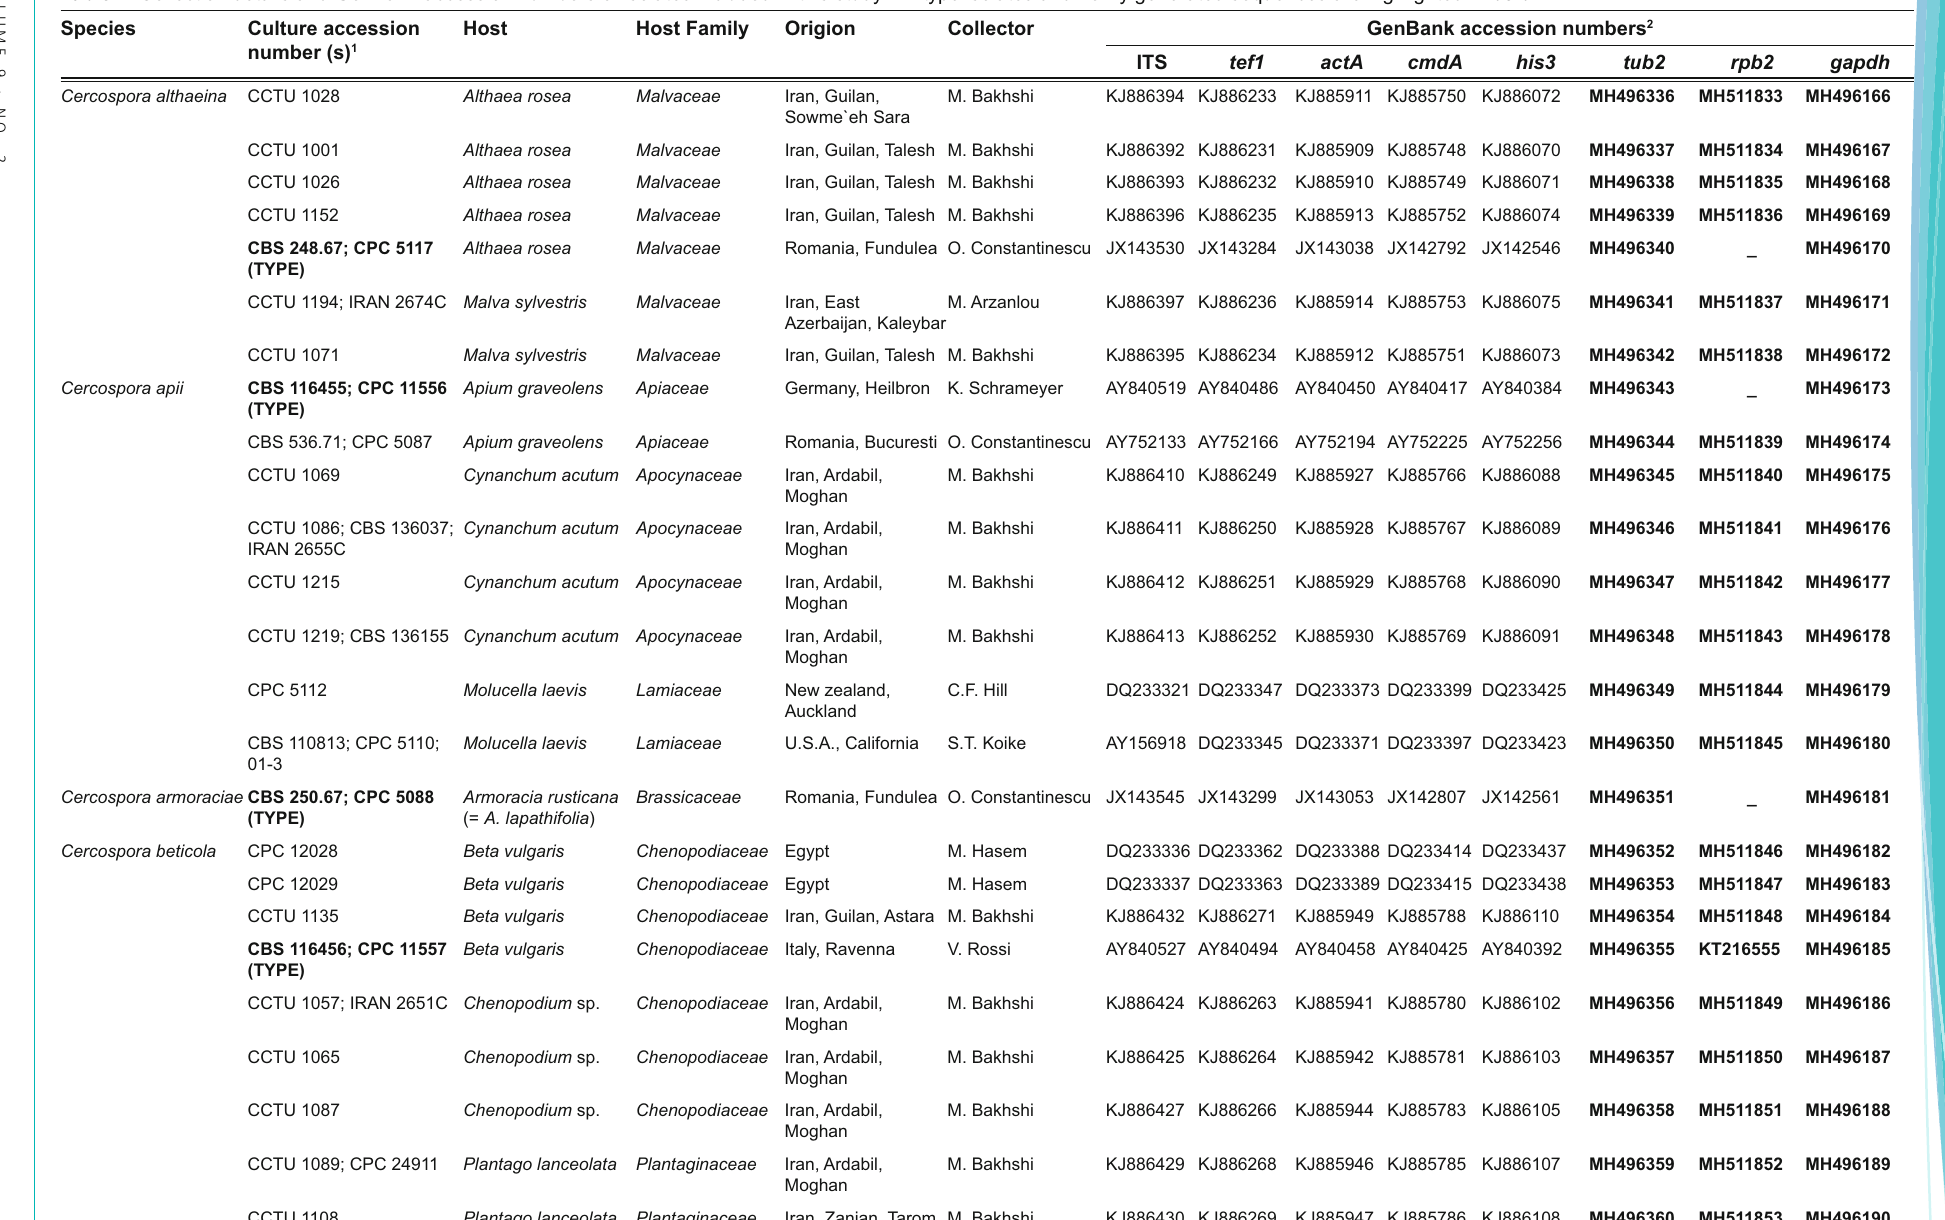
Table 1. %(cid:4)(cid:23)(cid:23)(cid:13)(cid:19)(cid:8)(cid:11)(cid:4)(cid:17)(cid:2)(cid:21)(cid:13)(cid:8)(cid:9)(cid:11)(cid:23)(cid:7)(cid:2)(cid:9)(cid:17)(cid:21)(cid:2)1(cid:13)(cid:17)’(cid:9)(cid:17)(cid:16)(cid:2)(cid:9)(cid:19)(cid:19)(cid:13)(cid:7)(cid:7)(cid:11)(cid:4)(cid:17)(cid:2)(cid:17)(cid:5)(cid:6)(cid:12)(cid:13)(cid:10)(cid:7)(cid:2)(cid:4)(cid:26)(cid:2)(cid:11)(cid:7)(cid:4)(cid:23)(cid:9)(cid:8)(cid:13)(cid:7)(cid:2)(cid:11)(cid:17)(cid:19)(cid:23)(cid:5)(cid:21)(cid:13)(cid:21)(cid:2)(cid:11)(cid:17)(cid:2)(cid:8)(cid:14)(cid:11)(cid:7)(cid:2)(cid:7)(cid:8)(cid:5)(cid:21)(cid:22)(cid:28)(cid:2)(cid:31)64(cid:8)(cid:22)(cid:18)(cid:13)(cid:2)(cid:11)(cid:7)(cid:4)(cid:23)(cid:9)(cid:8)(cid:13)(cid:7)(cid:2)(cid:9)(cid:17)(cid:21)(cid:2)(cid:17)(cid:13)(cid:15)(cid:23)(cid:22)(cid:2)(cid:25)(cid:13)(cid:17)(cid:13)(cid:10)(cid:9)(cid:8)(cid:13)(cid:21)(cid:2)(cid:7)(cid:13)T(cid:5)(cid:13)(cid:17)(cid:19)(cid:13)(cid:7)(cid:2)(cid:9)(cid:10)(cid:13)(cid:2)(cid:14)(cid:11)(cid:25)(cid:14)(cid:23)(cid:11)(cid:25)(cid:14)(cid:8)(cid:13)(cid:21)(cid:2)(cid:11)(cid:17) bold (cid:28) Species Cercospora althaeina